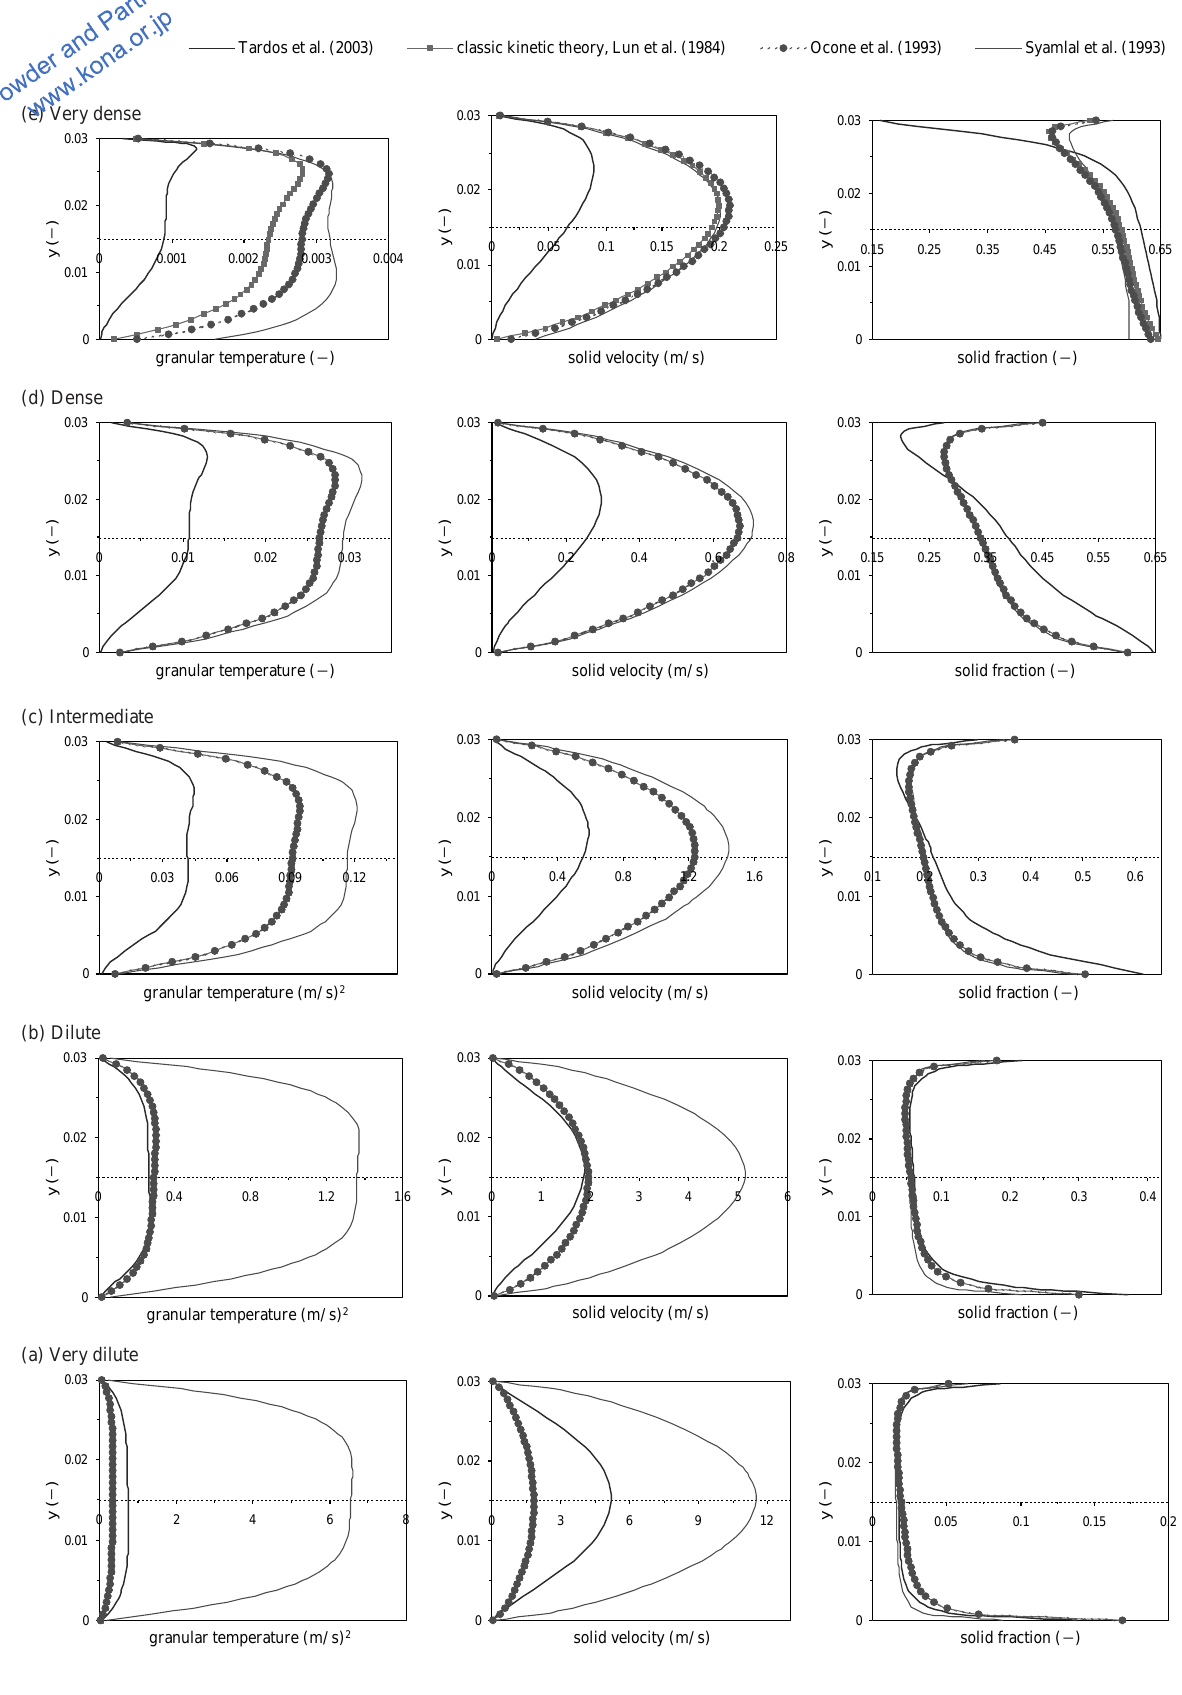
Fig. 12 Hydrodynamic predictions of a wide range of gas-solid flow in a horizontal duct predicted by different shear modelling